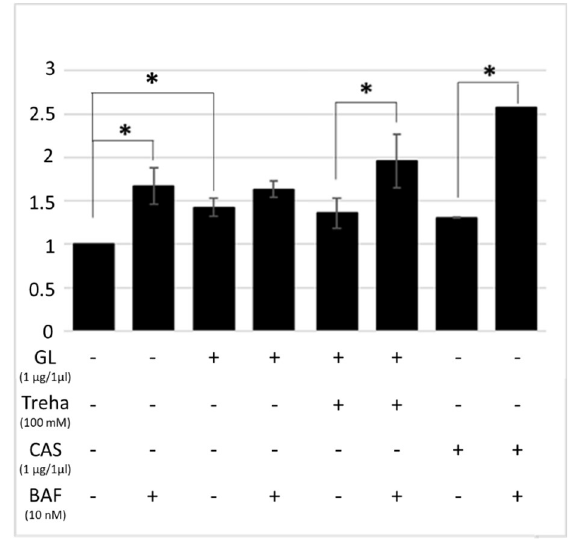
Figure 14. Cytofluorimetric analysis of LC3-II levels in HT-29 cells treated with digested gliadin (1 µg/µL) in presence/absence of trehalose (100 mM). Bafilomycin A1 (10 nM) was used to monitor the autophagic flux. The LC3-II expression values were normalized on the NT sample. The analysis was performed using a Muse ® Cell Analyzer (Merck). The asterisks indicate p < 0.05, ANOVA one-way, as compared with the relative control samples. SE bars are reported. The experiments were performed in triplicate. Cytofluorimetric plot are reported in Supplementary Figure 11.